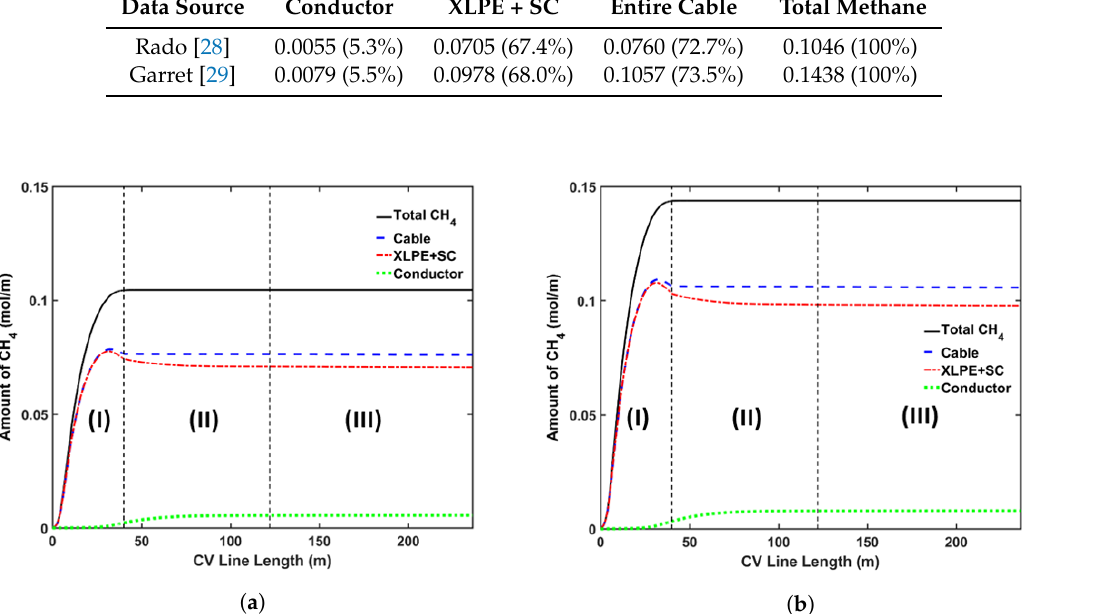
Figure 9. Axial CH 4 concentration profile across the CV line, computed based on two different cross-linking reaction selectivity profiles. The reaction selectivity profile based on Rado’s data [28] and Garrett’s data [29] was used for computing the reaction selectivity in ( a , b ), respectively. Segments (I), (II), and (III) correspond to the curing tube and transition zone, water-cooling, and air-cooling segments, respectively.